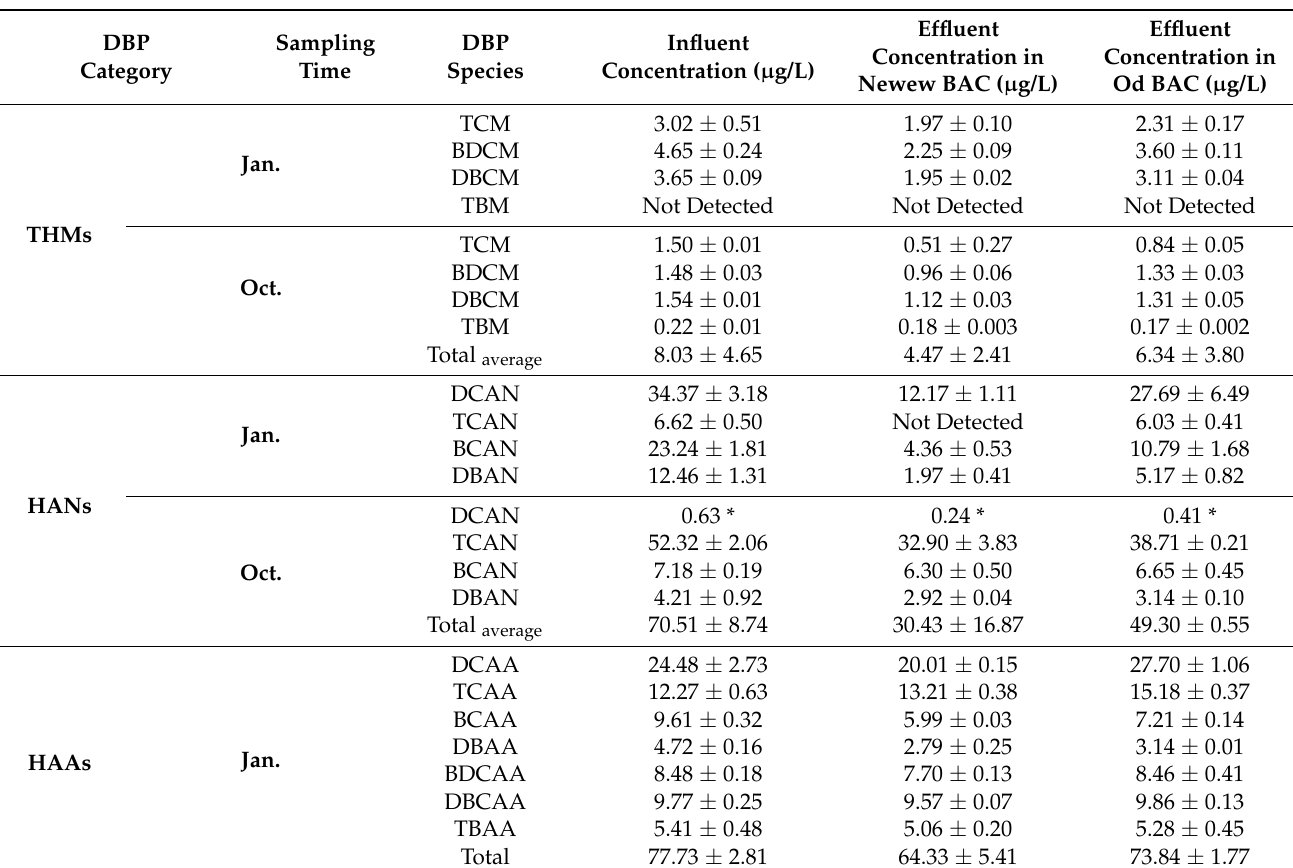
Table 5. Formation potential of THMs, HAAs, and HANs during chloramination of the influent and the effluent of old and new BAC filters. ( n =